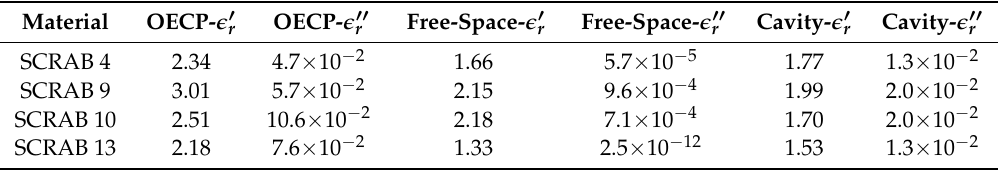
Figure 9. Measurement of a SCRAB-II slab material in a split cavity resonator. Table 4. SCRAB-II materials under test. Extracted mean permittivity (f = 8–13 GHz) for OECP, free-space and split cavity